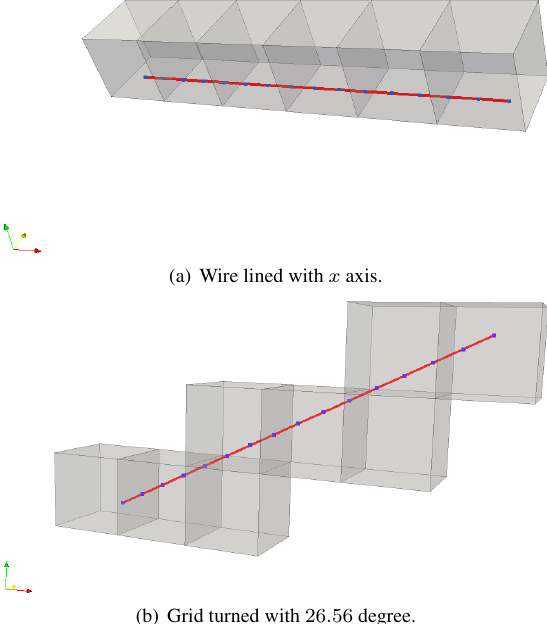
Figure 7: Configurations for the first test